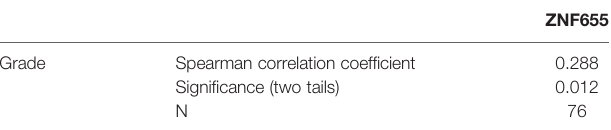
TABLE 3 | Relationship between ZNF655 expression and tumor characteristics in patients with high-grade glioma.